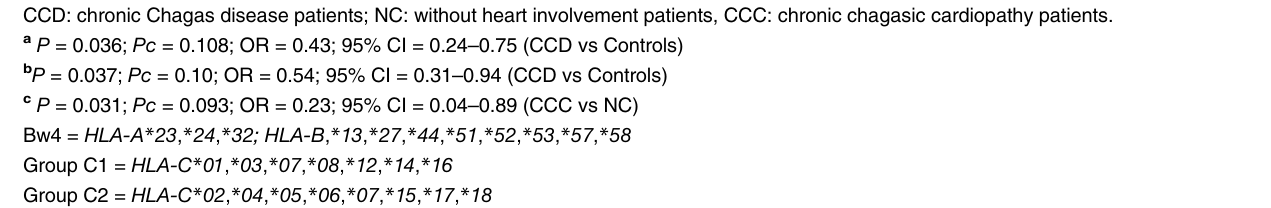
CCD: chronic Chagas disease patients; NC: without heart involvement patients, CCC: chronic chagasic cardiopathy patients. a P = 0.036; Pc = 0.108; OR = 0.43; 95% CI = 0.24 – 0.75 (CCD vs Controls) b P = 0.037; Pc = 0.10; OR = 0.54; 95% CI = 0.31 – 0.94 (CCD vs Controls) c P = 0.031; Pc = 0.093; OR = 0.23; 95% CI = 0.04 – 0.89 (CCC vs NC) Bw4 = HLA-A * 23 , * 24 , * 32; HLA-B , * 13 , * 27 , * 44 , * 51 , * 52 , * 53 , * 57 , *